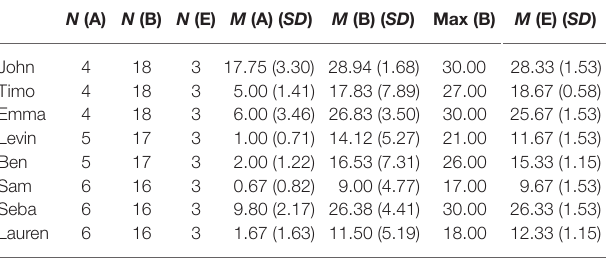
TABLE 2 | Descriptive data for each participant in phases A, B, and E. TABLE 3 | Overlap indices for the number of words read correctly comparing phases A and